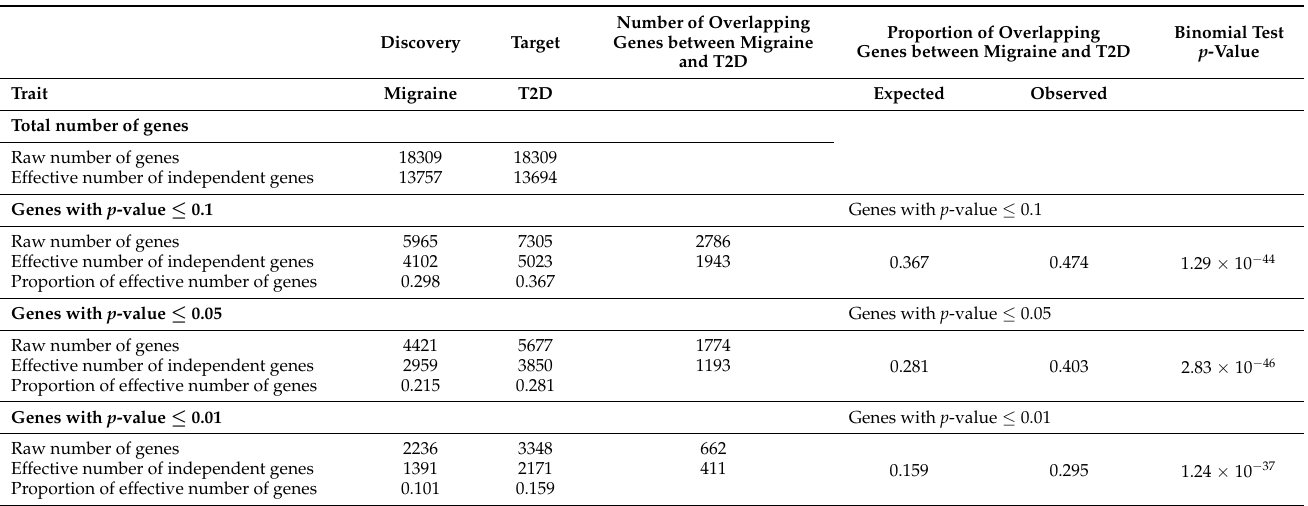
Table 5. Results for independent gene-based and gene-level genetic overlap analysis between migraine and T2D.